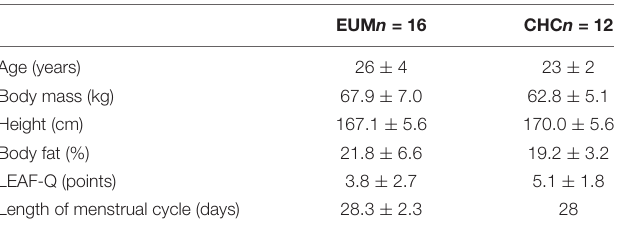
TABLE 1 | Participant information for the eumenorrheic (EUM) women and the monophasic hormonal contraceptive users (CHC).